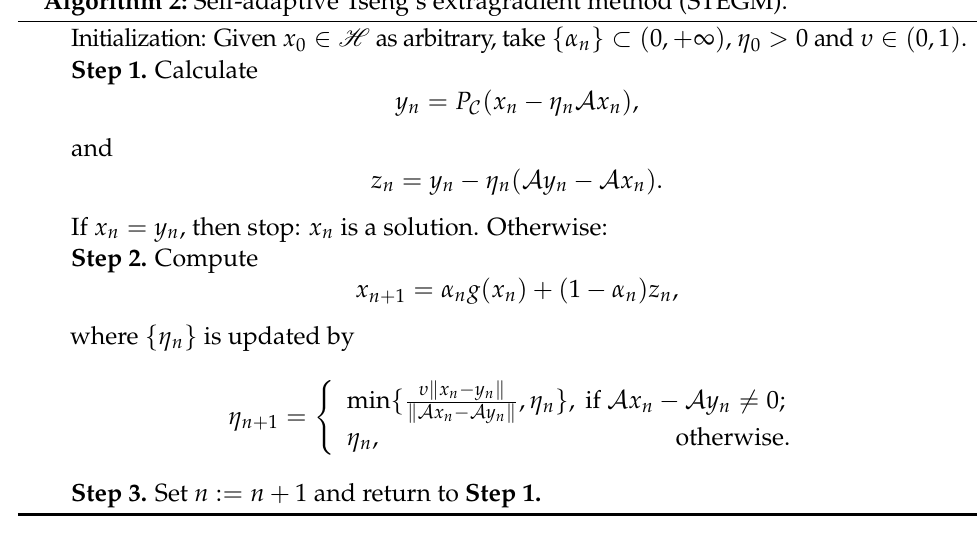
Algorithm 2: Self-adaptive Tseng’s extragradient method (STEGM).